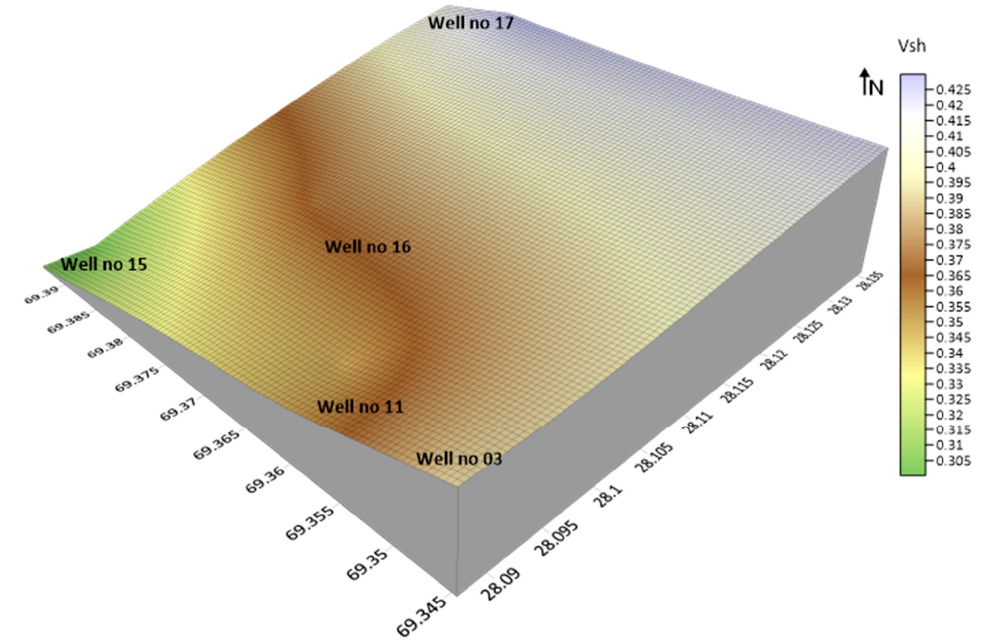
Figure 12. QGF volume of shale (Vsh) variation map computed in (%).